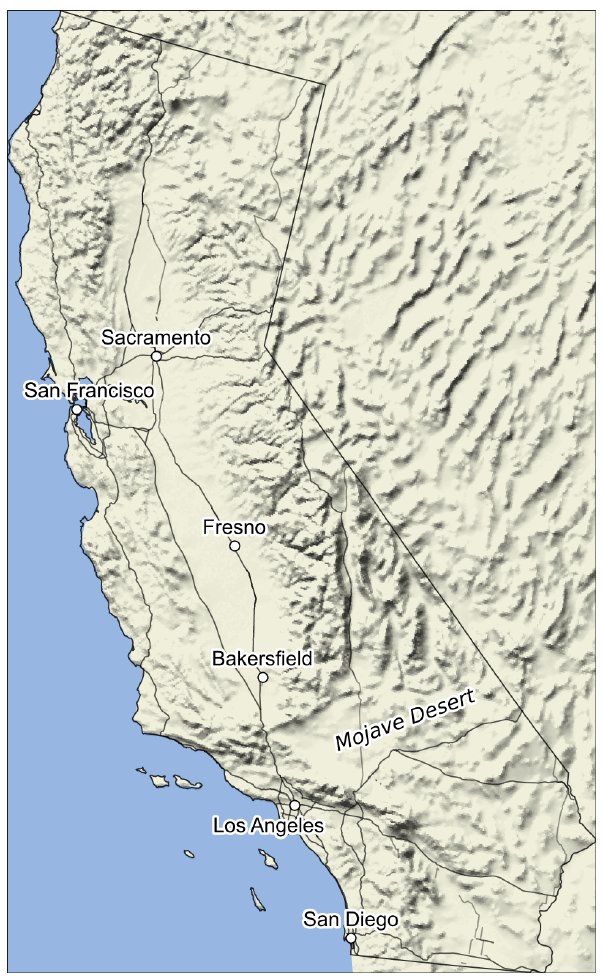
Figure C2. Map of the California. Locations discussed in the text and locations with notable features in Fig. 9 are marked.